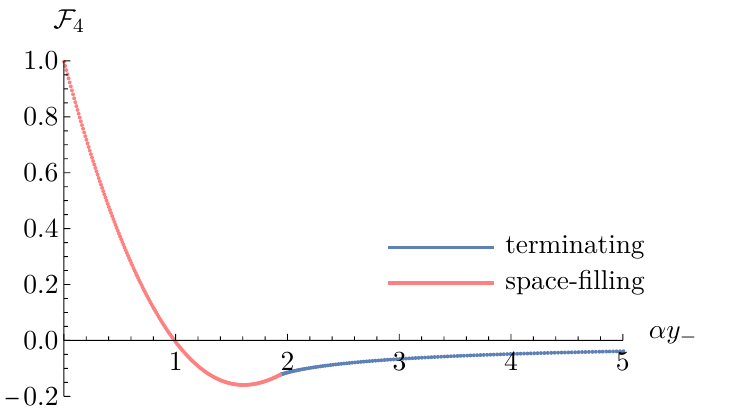
Figure 5. Free energy in the IR finite scheme ( b 3 , b 1 ) = (0 , 0)